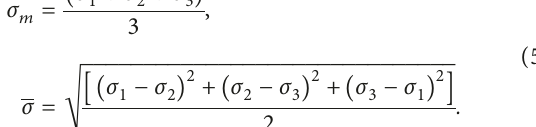
Figure 3: True stress-strain for steel material.